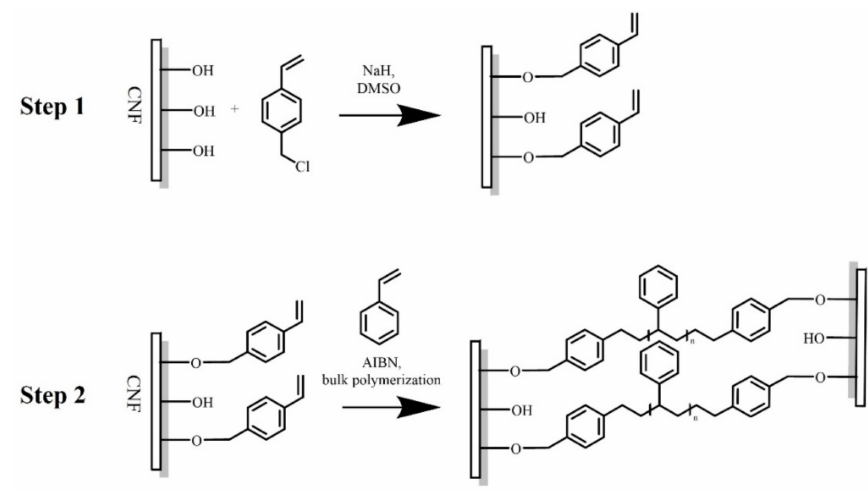
Scheme 1. Surface modification of CNF and subsequent copolymerization with St.